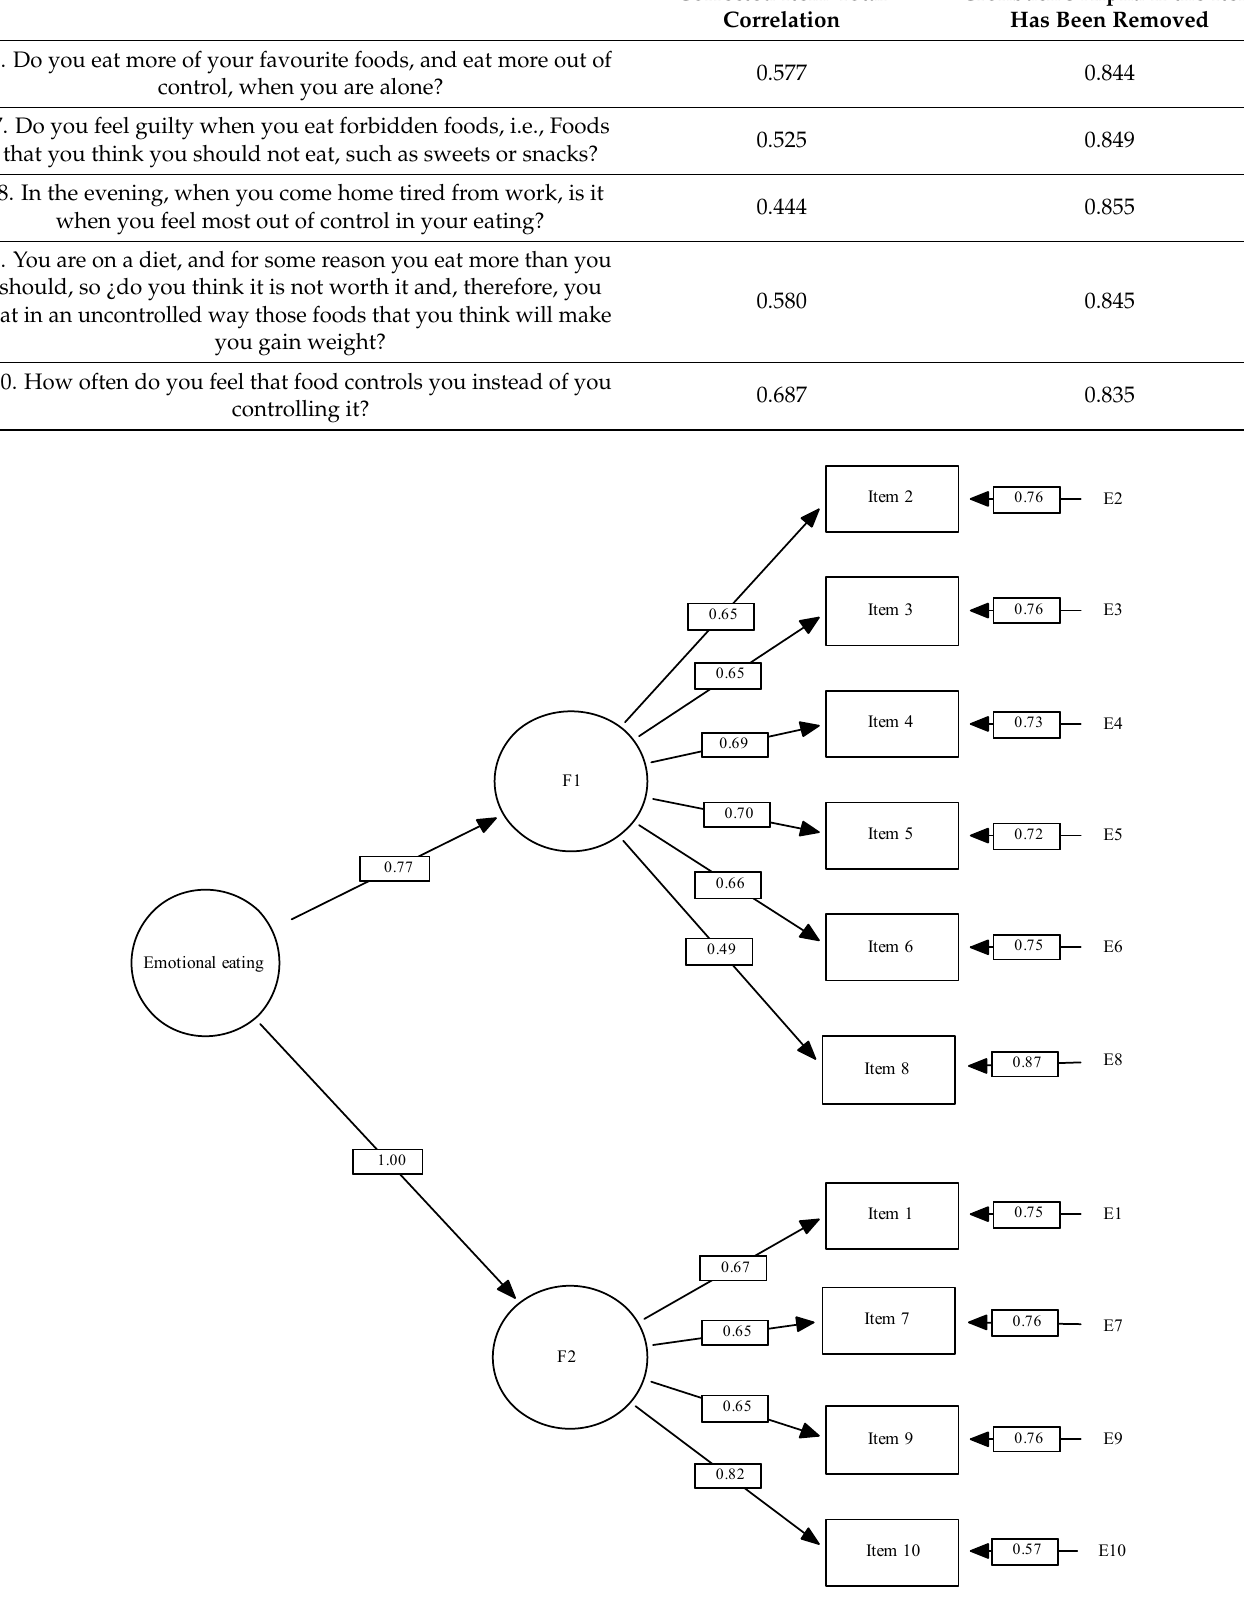
Figure 1. Factor structure of the proposed model for the Emotional Eater Questionnaire. Model 3: Standardized factor weights and residuals. Figure 1 legend: F1: Impulsive Eating; Factor 2: Mood/Affect. E1–E10 refer to the residual errors of the observed scores of each item; this is an expression of the variance not explained by the latent variables.